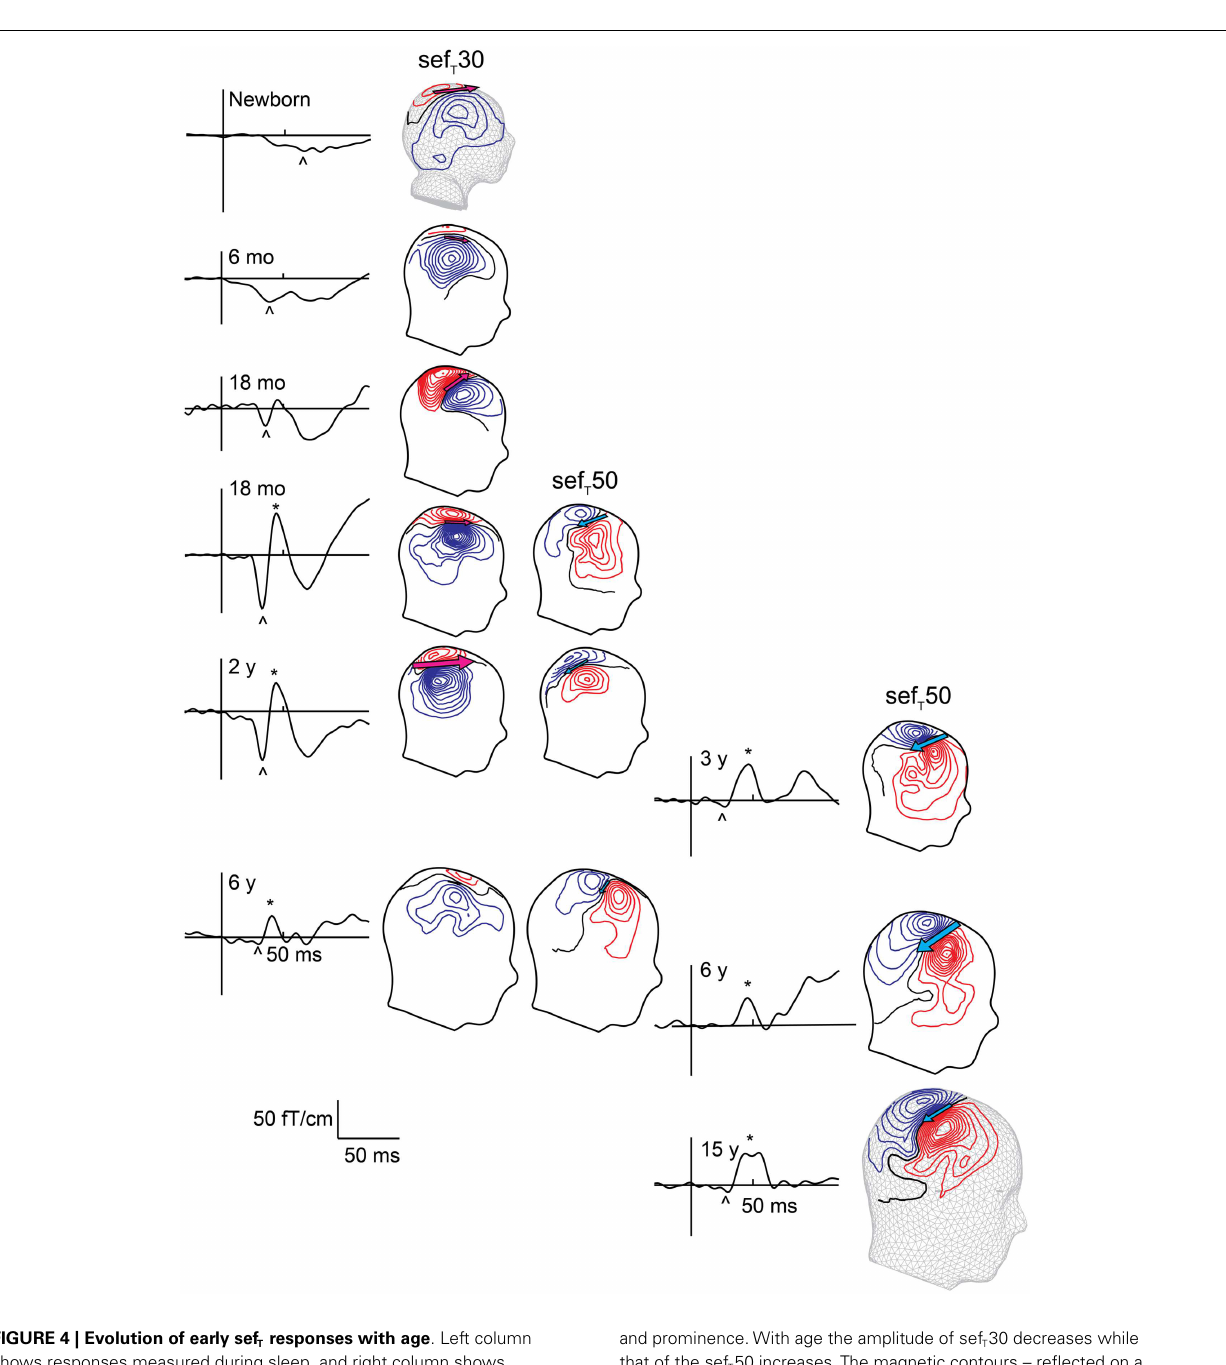
and prominence.With age the amplitude of sef T 30 decreases while that of the sef T 50 increases.The magnetic contours – reflected on a head surface – reveal the different current orientations (indicated by the pink and blue arrows) underlying the sef T 30 and sef T 50: during the sef T 30 the underlying current points anteriorly, and during the sef T 50